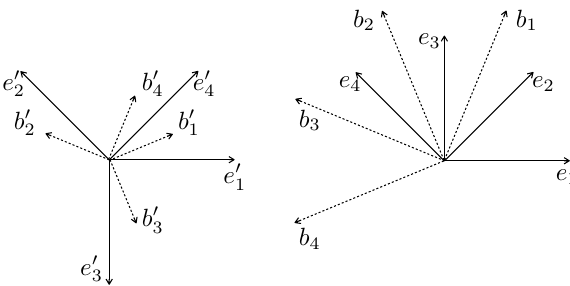
Figure 3. Projections of the bases { ε n } of Z 4 and { β n } of the BCC lattice in P (cid:48) ( left ) and P ( right